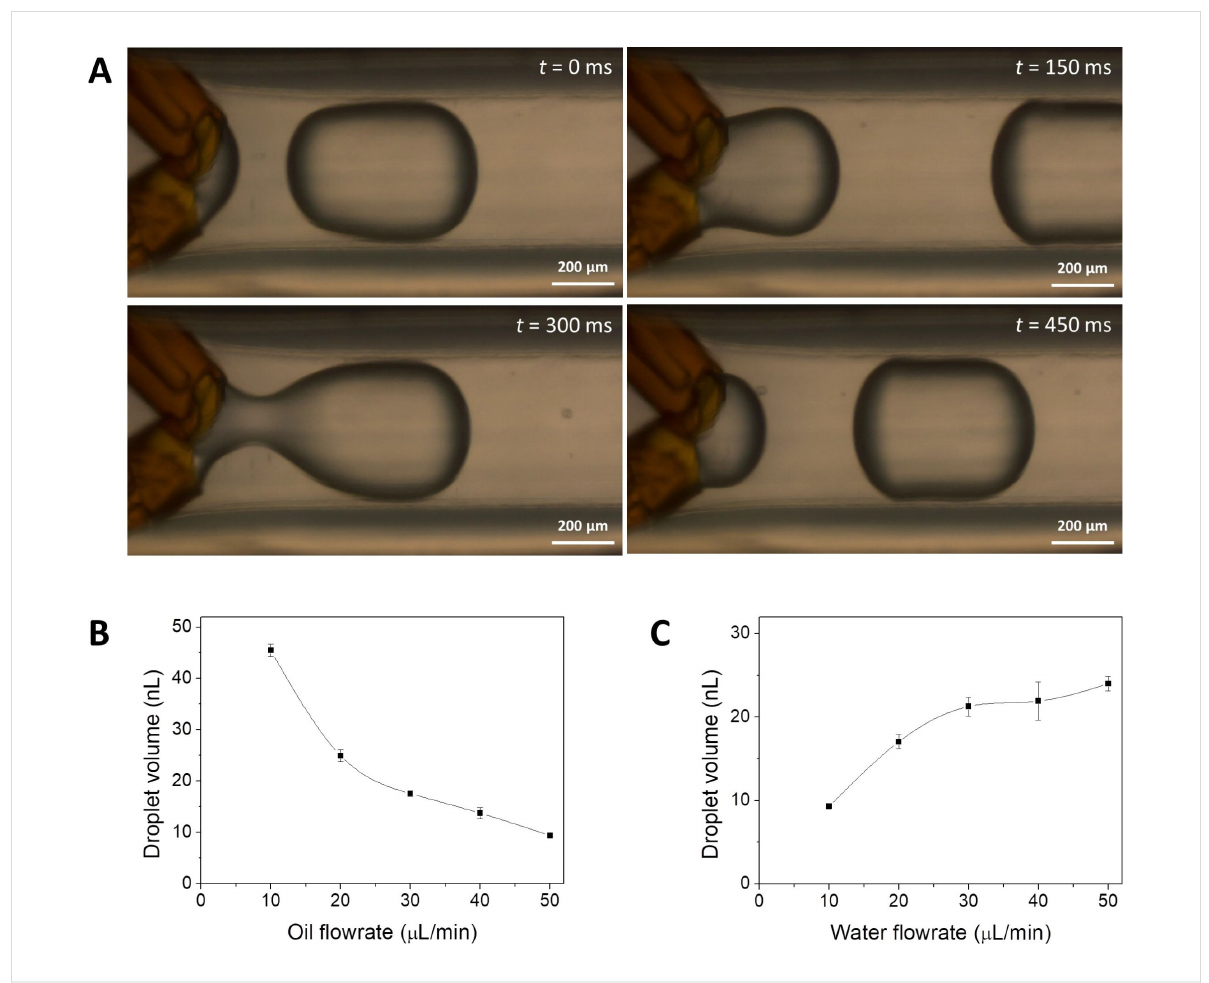
Figure 2: Time-lapse microscopy images of droplet generation inside the Tygon tubing (A). Graph of droplet volume as a function of oil flowrate at a water flowrate of 10 µL/min from both capillaries (B), and graph of droplet volume as a function of water flowrate at an oil flowrate of 50 µL/min (C). For the calculation of volumes 25 droplets were measured at each